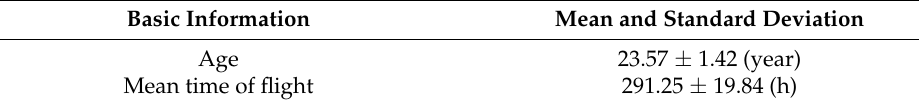
Table 1. Basic information of the